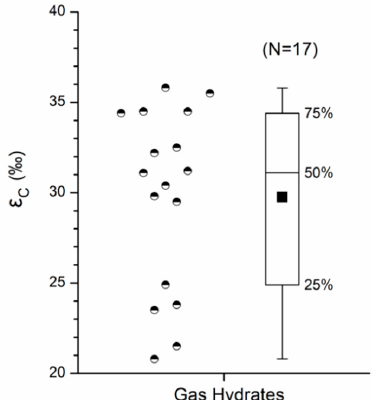
Figure 7. The boxplot of the calculated ε C values of gas hydrates in the Muli permafrost.